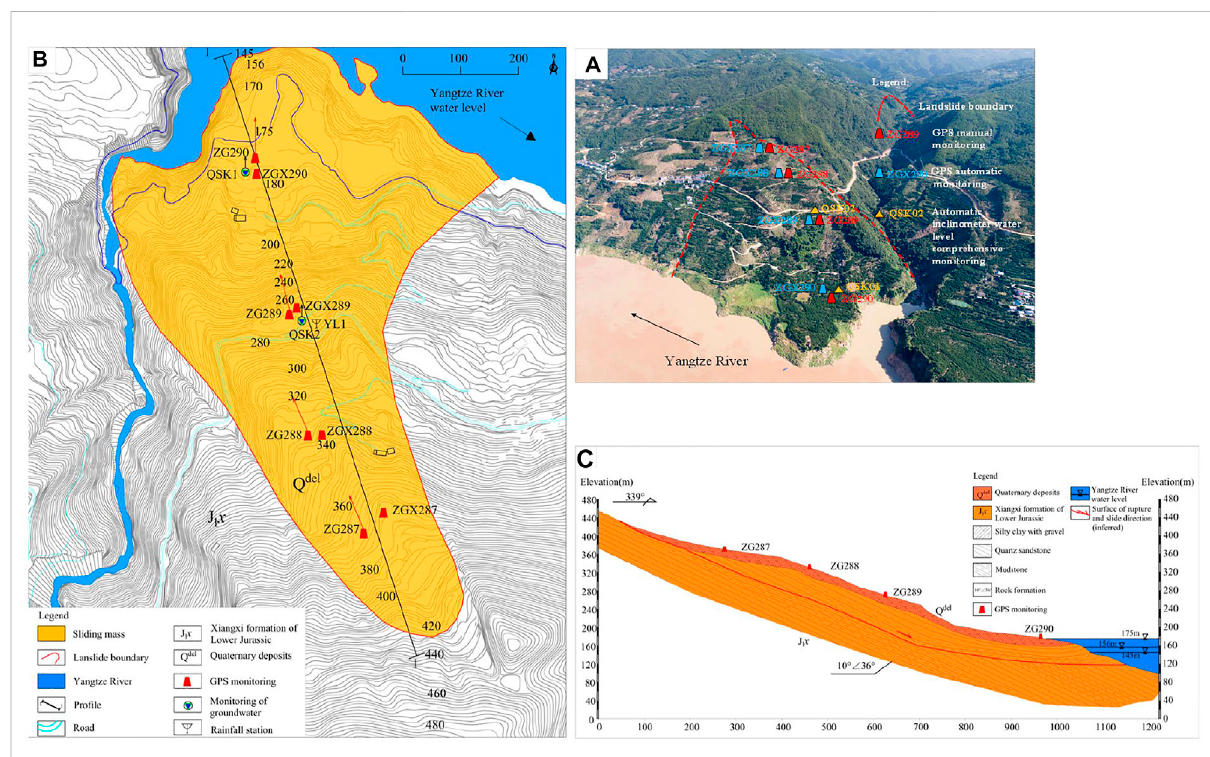
FIGURE 2 Tanjiahe landslide. (A) Panoramic view of the landslide. (B) Planar map of the landslide. (C) Geological pro fi le.